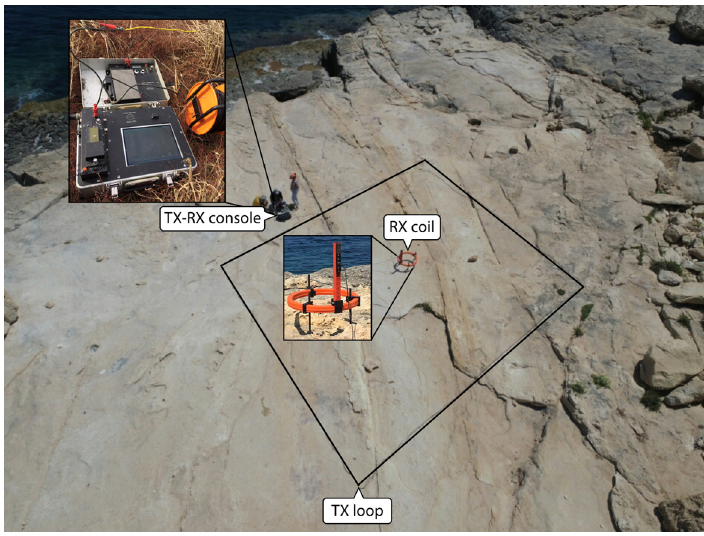
Figure 2. Field deployment of Geonics G ‐ TEM geophysical equipment in SE Malta.